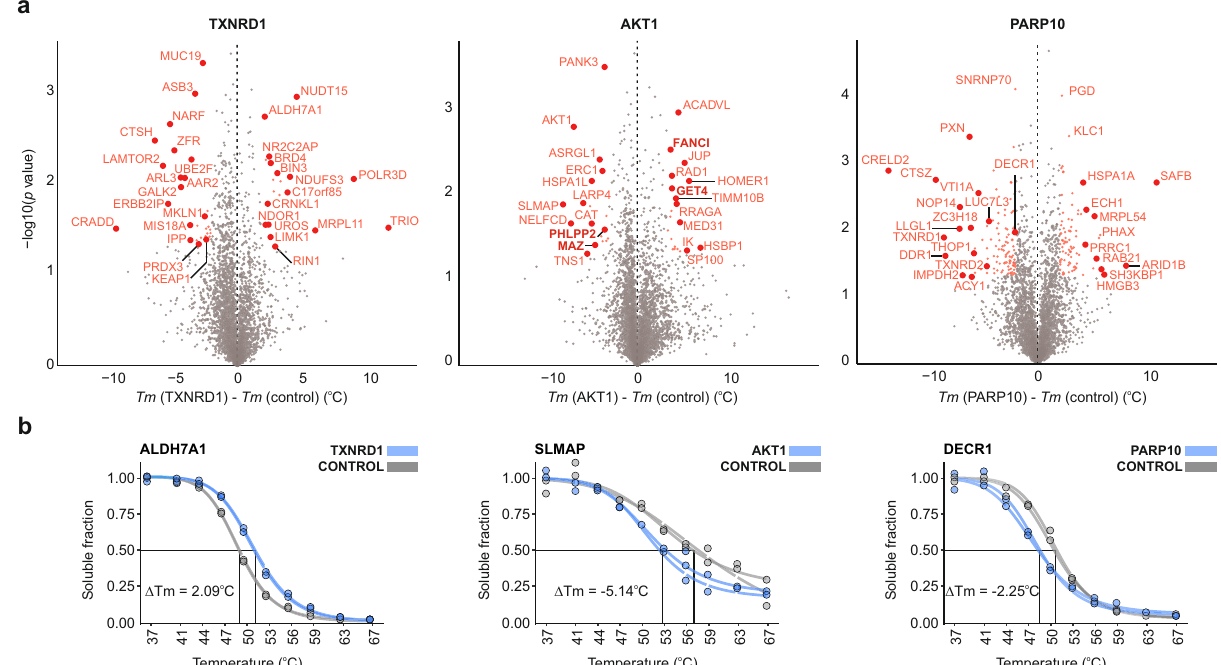
Fig. 5 TPP identi fi es protein interaction partners of enzymes added to cell lysates. a Proteins ’ Tm shifting with addition of only enzyme to cell lysate. The known proteins interacting with AKT1 are shown in bold red (FUNCI, GET4, PHLPP2, and MAZ) ( n = 2 independent biological replicates; two-sided Student t -test; no adjustment for multiple comparisons was performed). b Representative shifting proteins with each enzyme. DECR1 was also enriched in